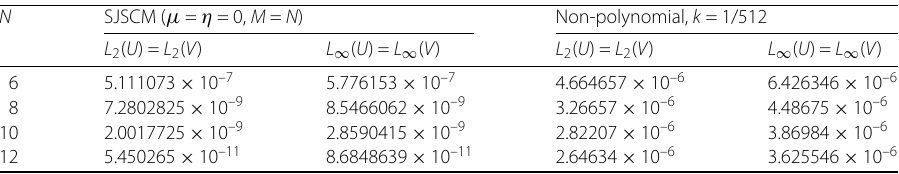
Table 2 L 2 and L ∞ error norms for u ( x , t ) = v ( x , t ) of Example 1 when 0 ≤ x ≤ 1, α 1 = α 2 = 0.4